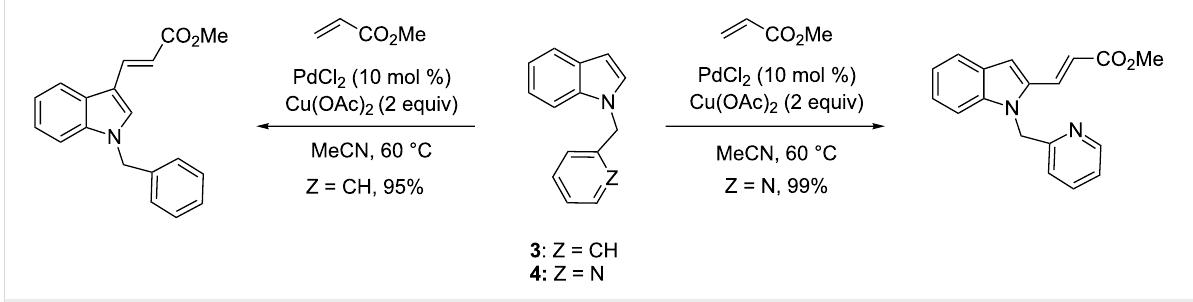
Scheme 5: Directing-group control in intermolecular indole alkenylation.